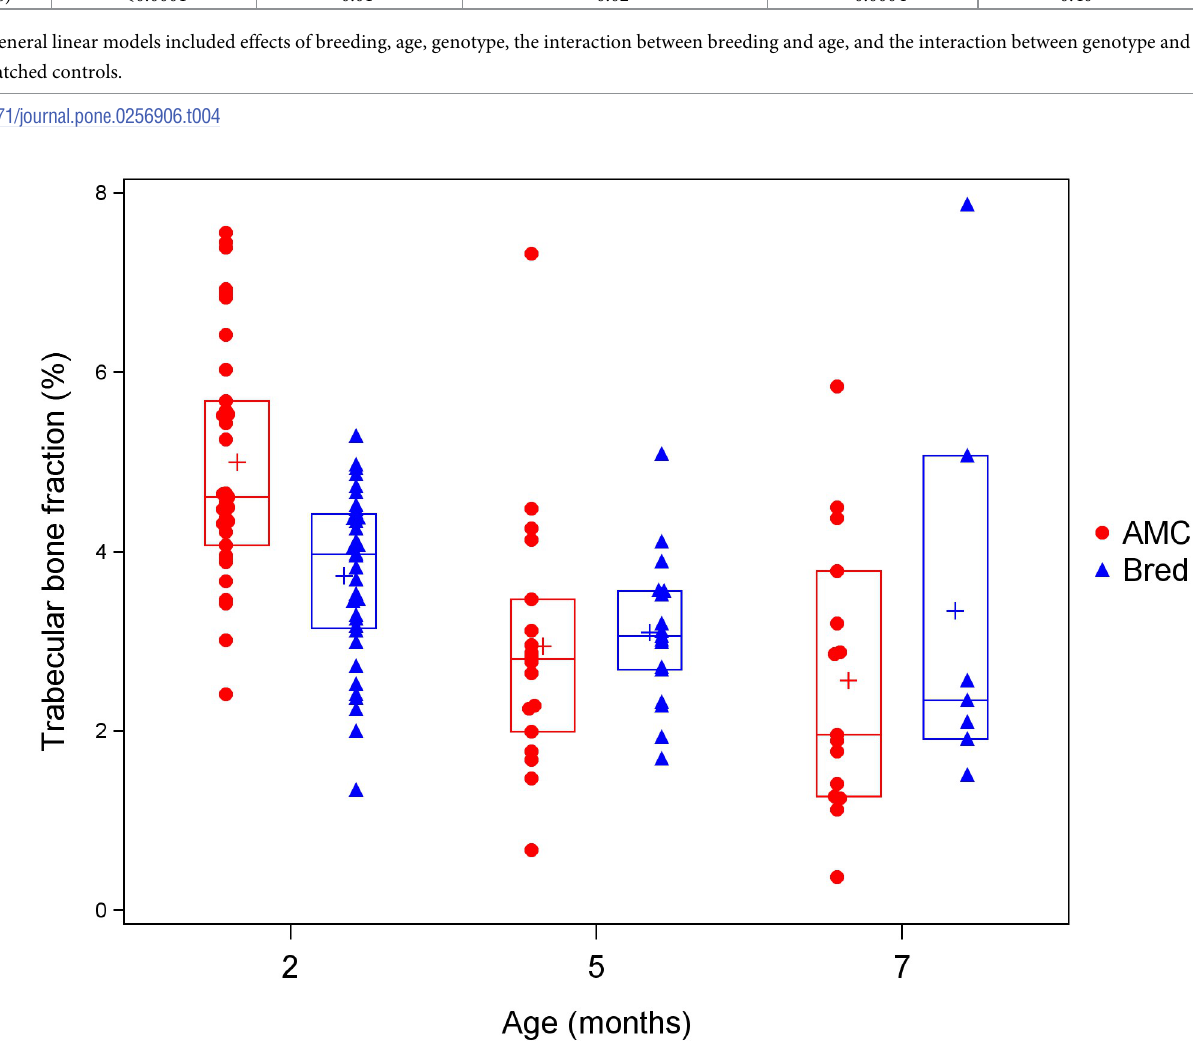
Fig 3. Effects of age and lactation on trabecular bone fraction among mice collected 3 weeks after weaning. Blue triangles denote bred mice, and red circles denote age-matched controls (AMC). Crosses denote means, while horizontal lines denote the 25th, 50th and 75th